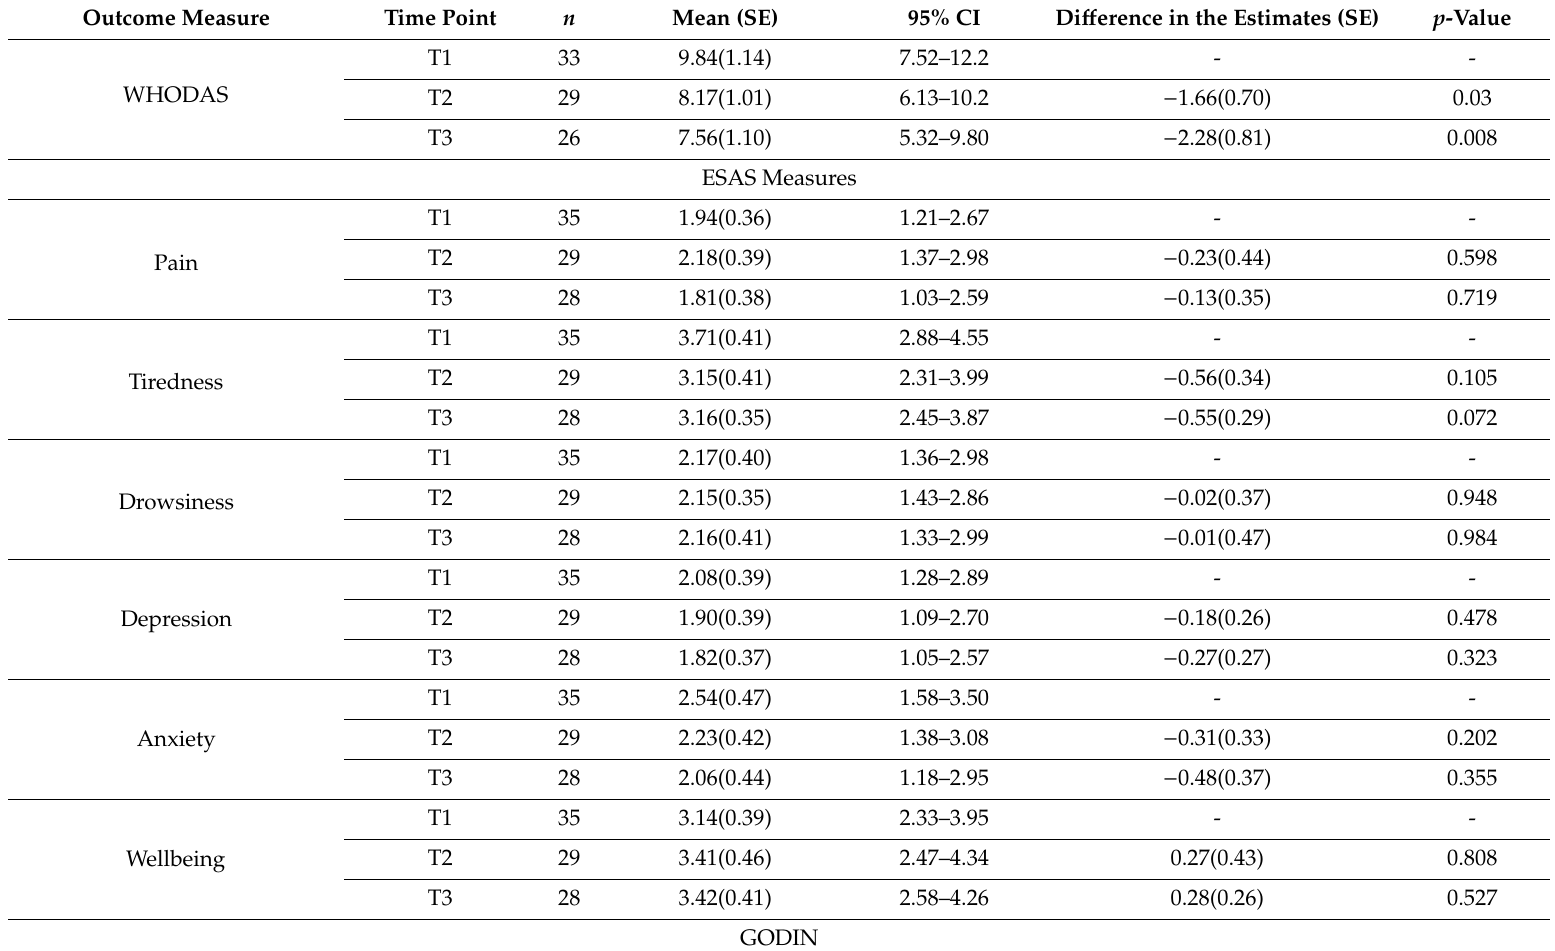
Table 5. Patient-Reported outcomes